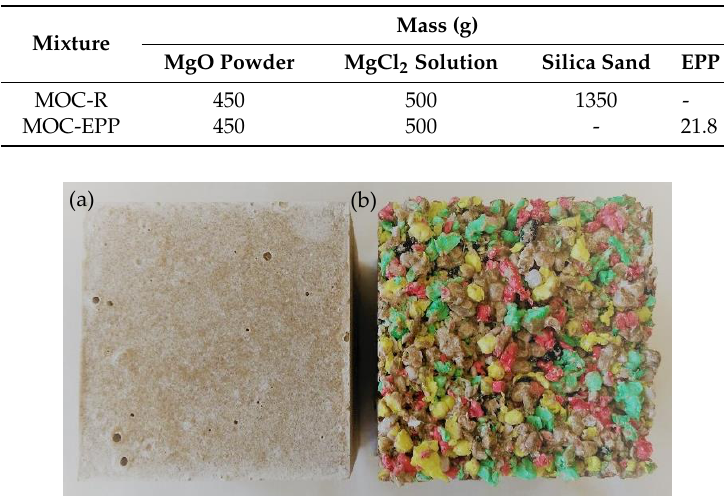
Figure 2. Tested MOC-R ( a ) and MOC-EPP ( b ) samples.